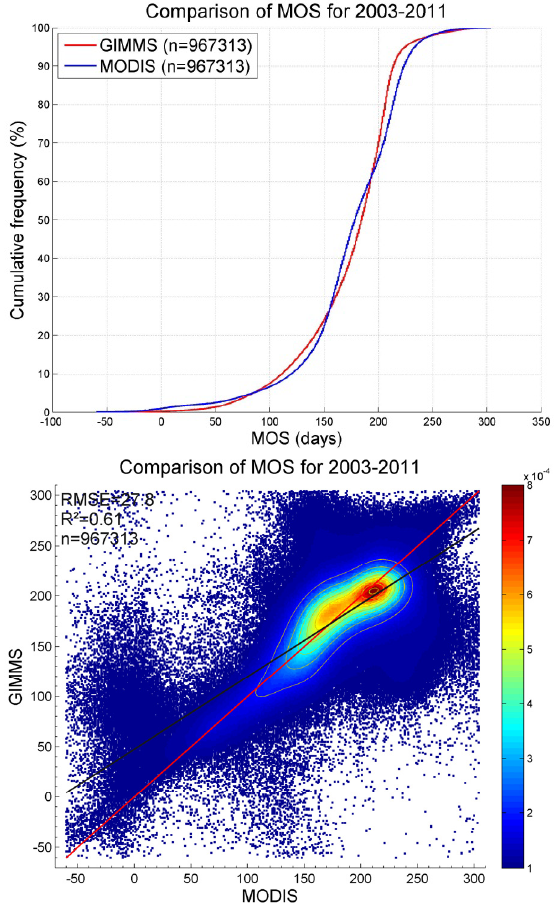
Figure 16. Maximum of season (MOS) derived from GIMMS and MODIS (full image extent and all data from 2003–2011. ( top ) cumulated frequency distribution, ( bottom ) scatterplot. In addition, also shown are the 1-to-1 line (red) and the regression line (black).